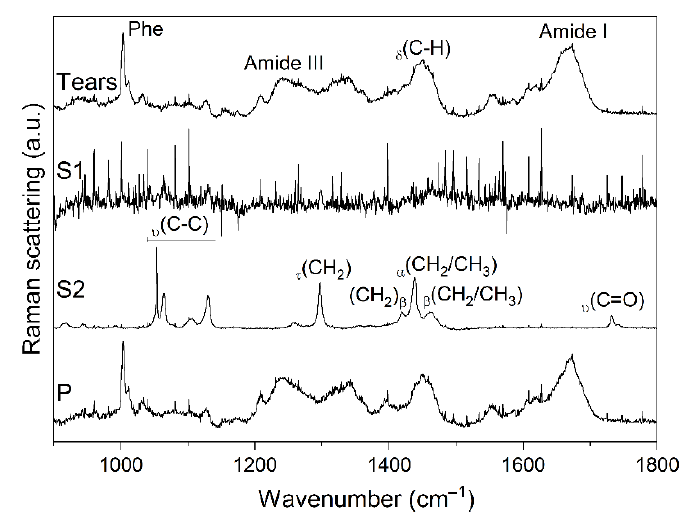
Figure 2. Raman (RS) spectra of protein extraction phases. Tears, unprocessed sample; S1, aqueous layer; S2, organic solvent layer; P, pellet. The assignment of selected peaks is shown, employing the annotation suggested by Czamara et al. (α, scissoring; β, bending; τ , twisting; υ, stretching) [24].